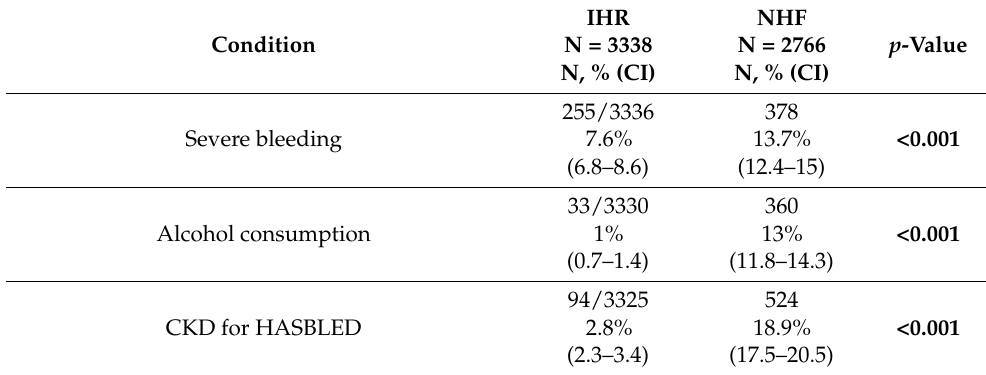
Table 3. Summary statistics of the cohort of AF patients in IHR and NHF